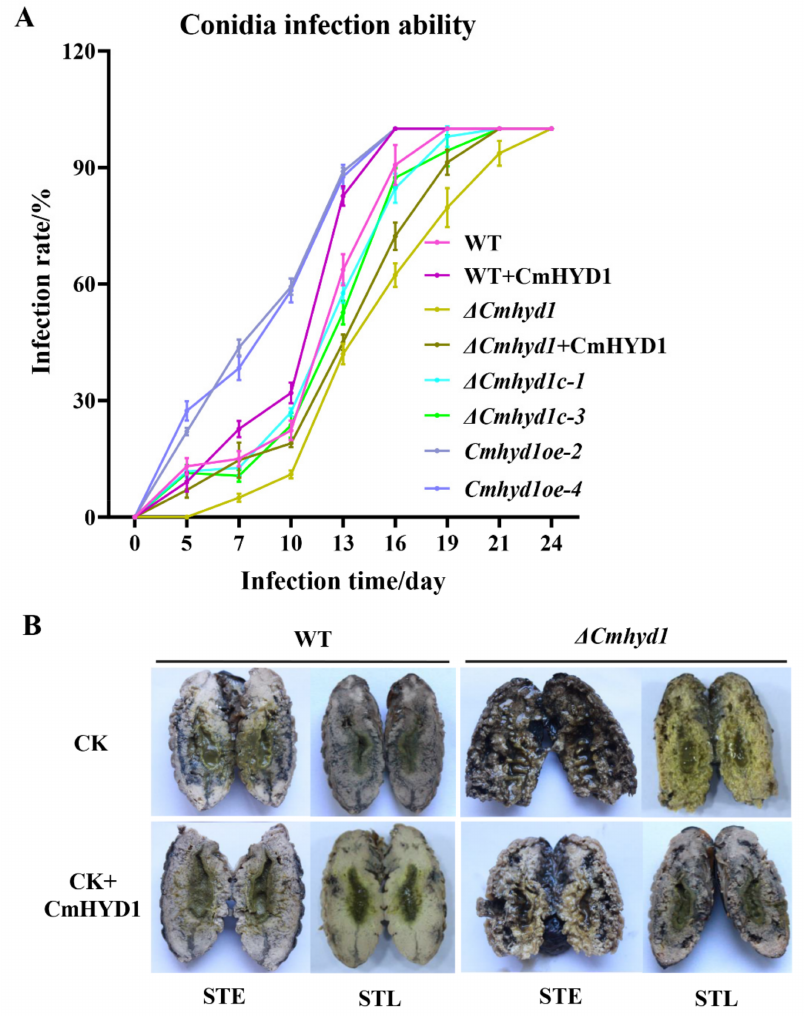
Figure 4. Cuticle-bypassing infecting ability of conidia of WT and mutants. ( A ) Infection rates of conidia and conidia with exogenous CmHYD1. ( B ) Longitudinal sections of silkworm pupae after being infected for 8 d (STE, early sclerotia) and 16 d (STL, late sclerotia) by conidia of WT, ∆ Cmhyd1 and addition of exogenous